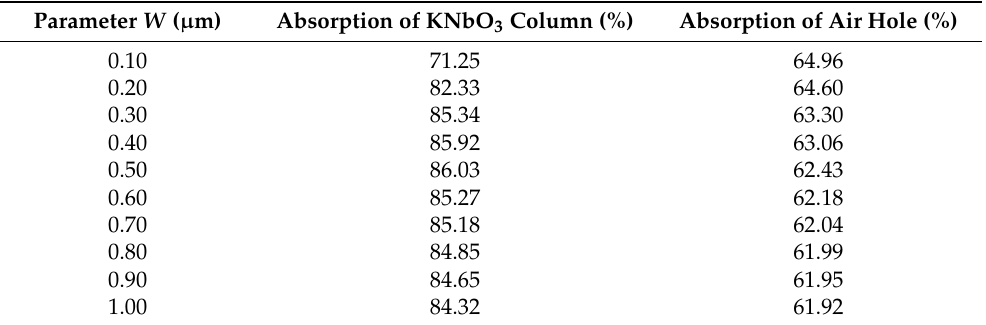
Table 2. The relationship between absorption efficiency of absorption layers with two different hexagonal scatterers and W.